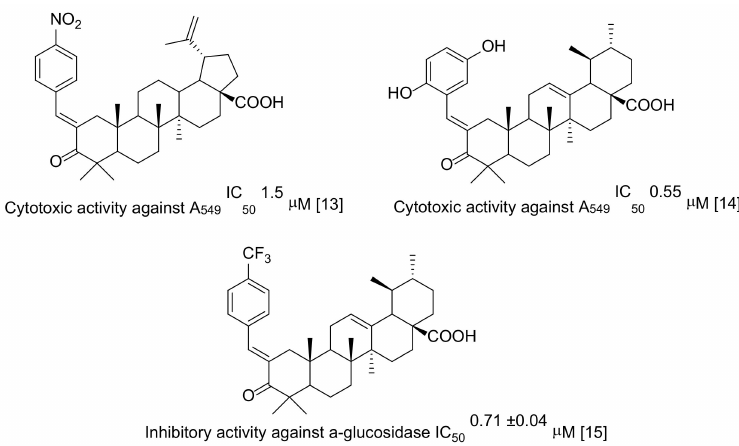
Figure 1. Biologically active triterpene C2-benzylidine